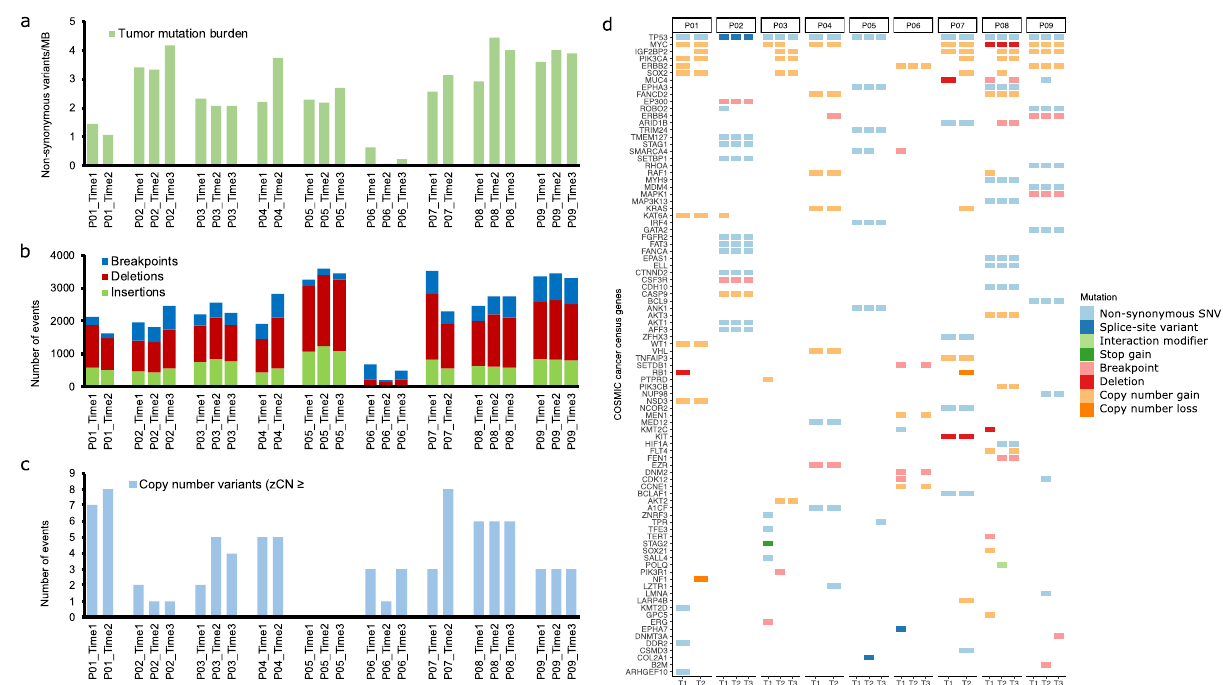
Fig. 5 Overview of somatic WGS variants in the longitudinal cohort. a Tumor mutation burden (non-synonymous SNVs and small indels/MB) in the longitudinal cohort samples. b Stacked bar plots showing the frequency of SVs, including indels (>25 bp) and breakpoints in each sample. c The number of genes with copy number alterations in each sample. The plot displays the number of genes that show a z-transformed copy number ≥ 2 (gain) or ≤ − 2 (loss). d Oncoprint displaying somatic variants affecting COSMIC cancer census genes. The plot displays SNVs and small indels with VAF> 0.05, large indels and breakpoints affecting exons, and CNVs with z-transformed copy number ≥ 2 (gain) or ≤ − 2